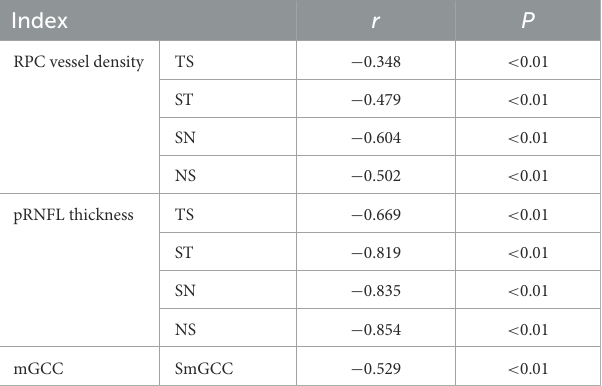
TABLE 4 Spearman correlation of time and OCTA-recorded retinal